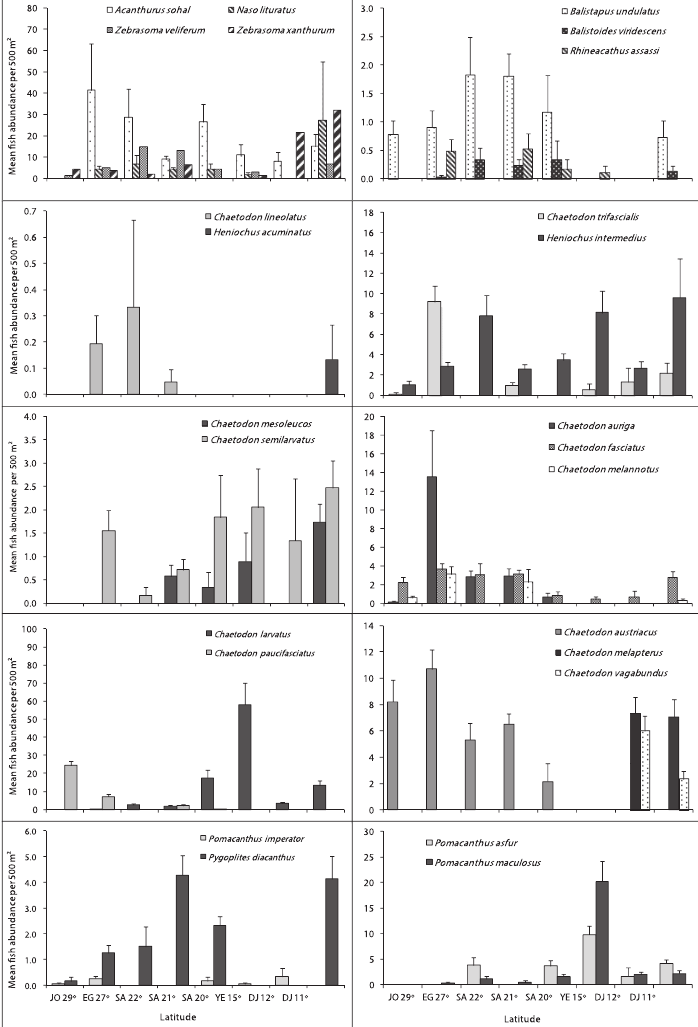
Figure 4. Differences in mean fish abundance per 500 m² transect according to latitudinal distribution for the families: Acanthuridae ( A. sohal, N. lituratus, Z. veliferum and Z. xanthurum) , Balistidae ( B. undulates , B. viridescens , and R. assassin) , Chaetodontidae ( C. lineolatus, H. acuminatus, C. mesoleucos, C. semilarvatus, C. auriga, C. fasciatus, C. melannotus, C. larvatus, C. paucifasciatus , C. austiacus , C. trifascialis, H. intermedius, C. melapterus , and C. vagabundus ), and Pomacanthidae ( P. asfur , P. imperator , P. maculosus and P. diacanthus